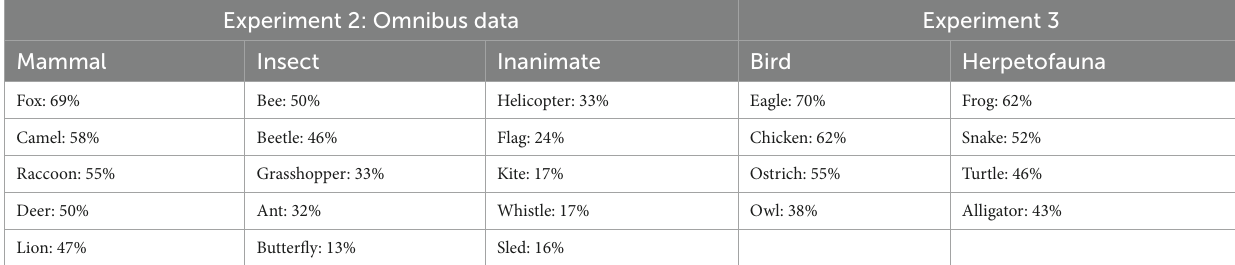
TABLE 1 Detection rates for each entity in Experiments 2 and 3. Experiment 2: Omnibus